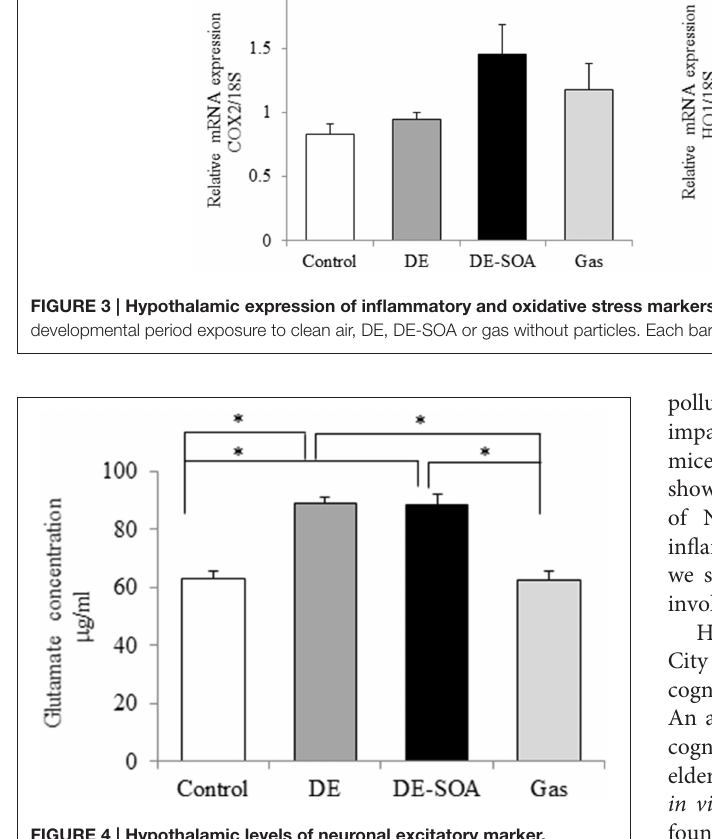
FIGURE 4 | Hypothalamic levels of neuronal excitatory marker. Glutamate concentration in the hypothalami of 13 week-old male mice after developmental period exposure to clean air, DE, DE-SOA or gas without particles. Each bar represents the mean ± SE ( n = 12 , * P < 0.05